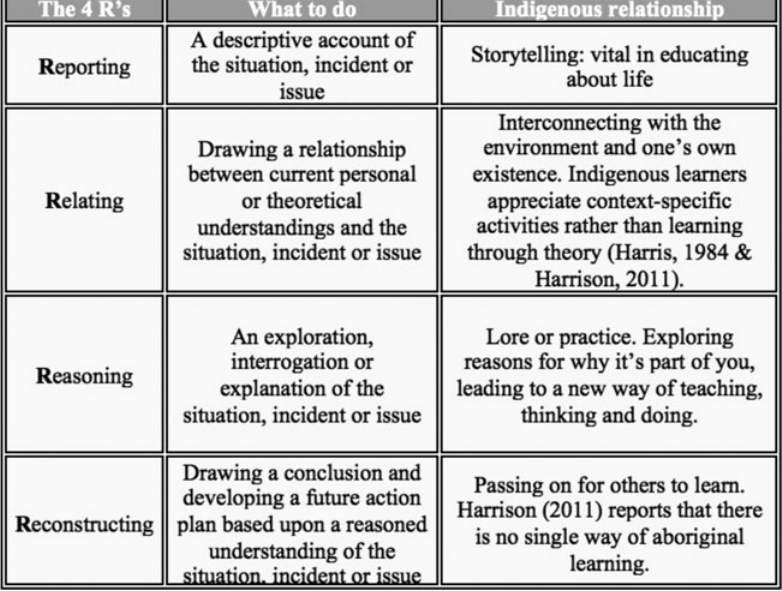
Reporting: A Descriptive Account of the Situation, Incident or Issue